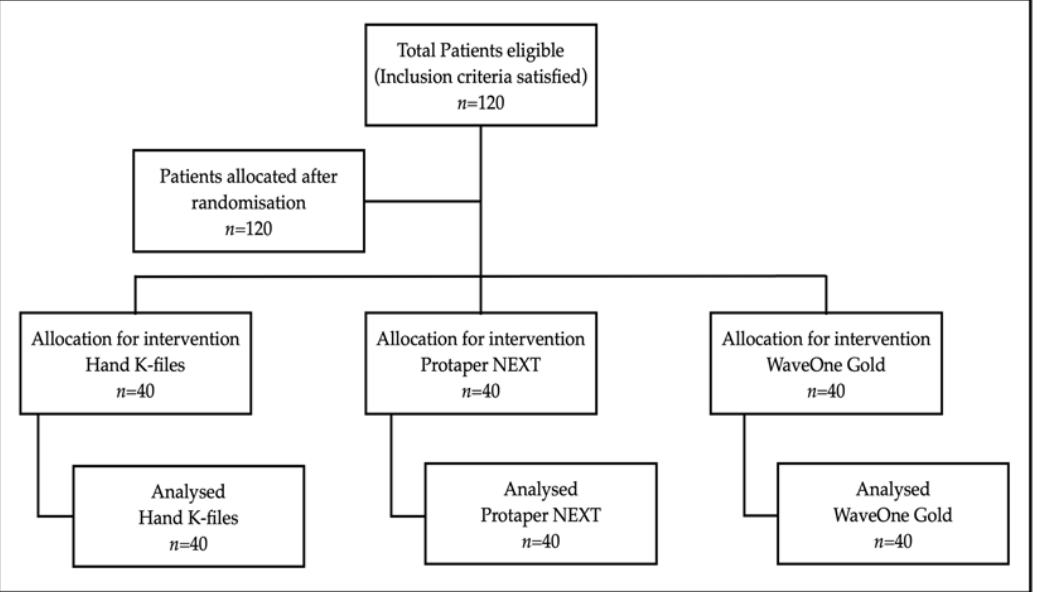
Figure 1. Flow diagram CONSORT for randomized clinical trial.